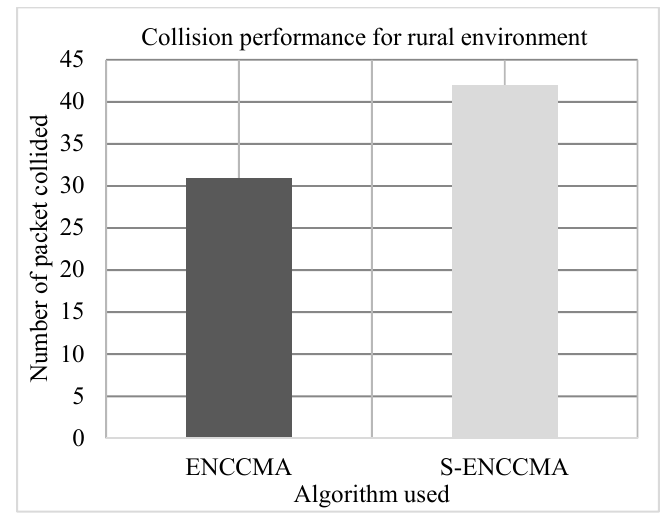
Figure 10. Collision performance achieved for a highway environment.